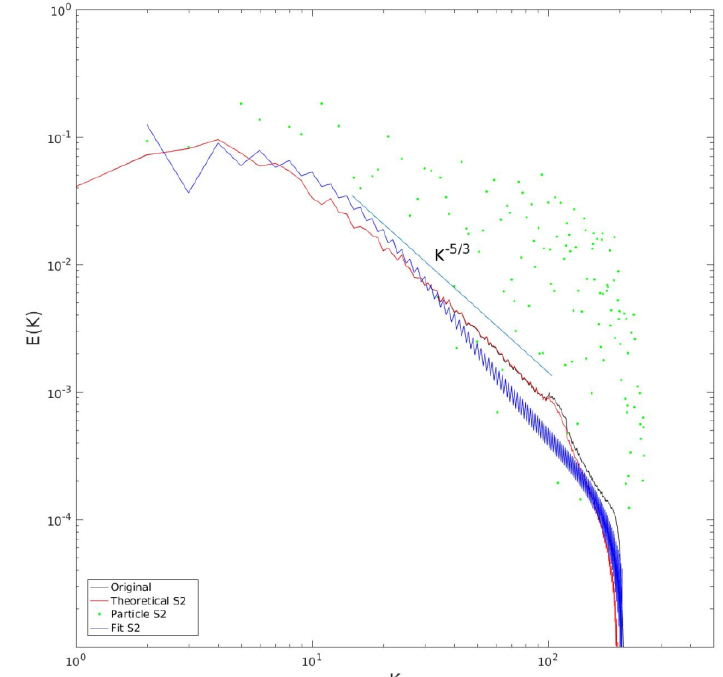
Figure 11. Spectral reconstructions from a simulation of a 2D inverse cascade, forced in the range K = [ 100,120 ] . The original spectrum is in black and the reconstruction from the theoretical structure function is in red . The green dots show the spectrum from the raw particle S 2 l and the blue curve shows that obtained with the polynomial fit S 2 l .